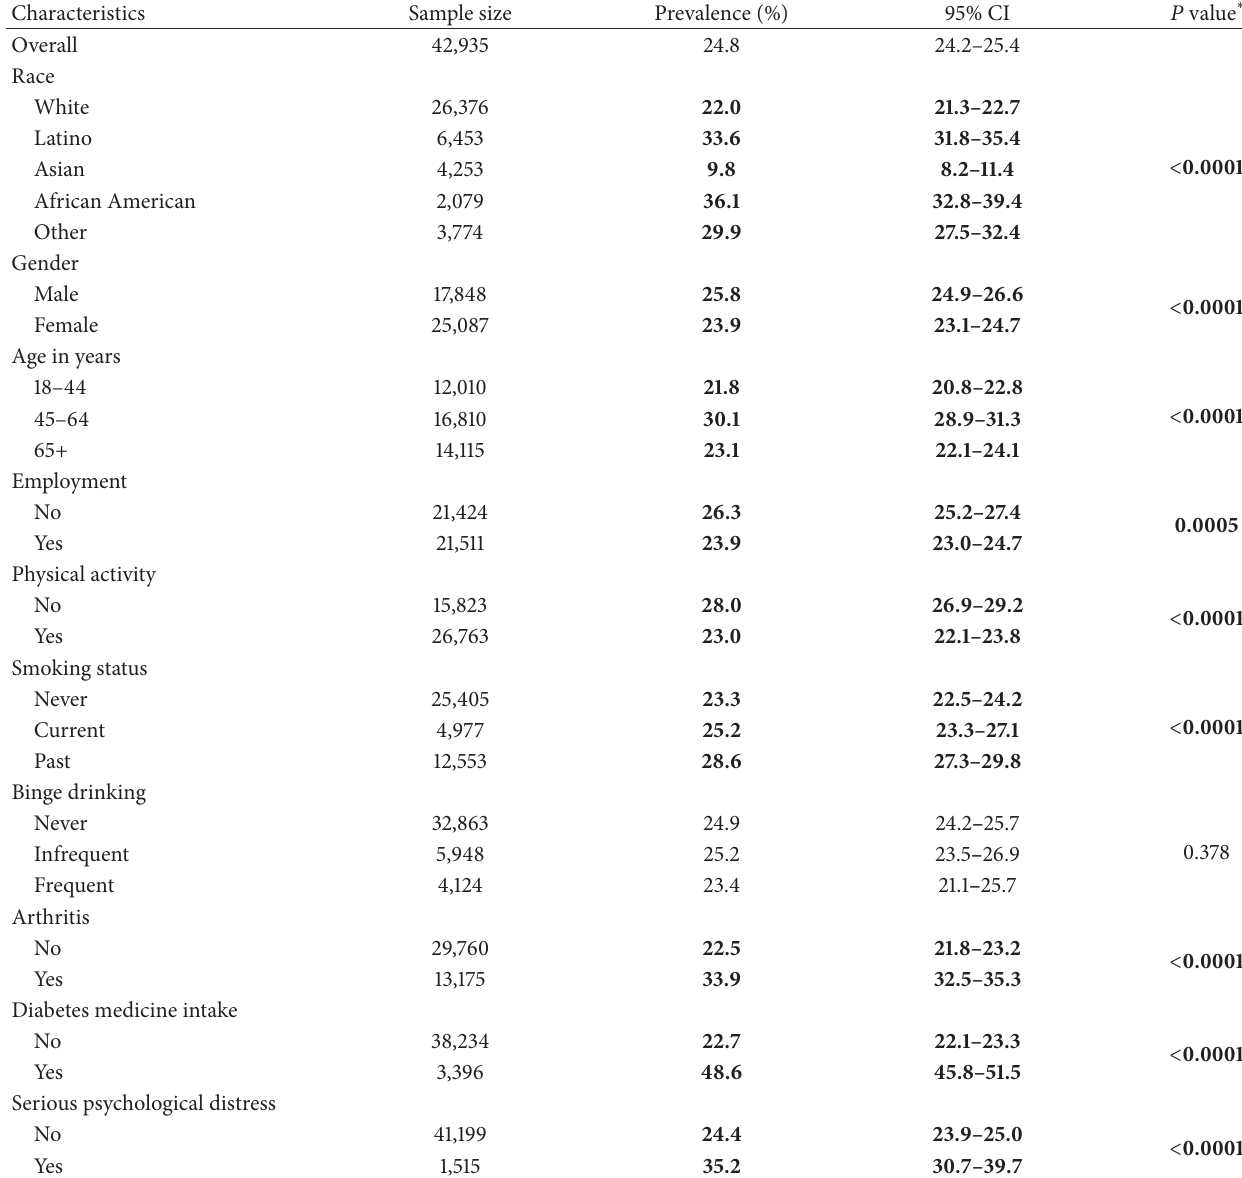
Table 1: The prevalence (%) of obesity according to characteristics of participants, the 2011-12 CHIS ( 𝑛 =